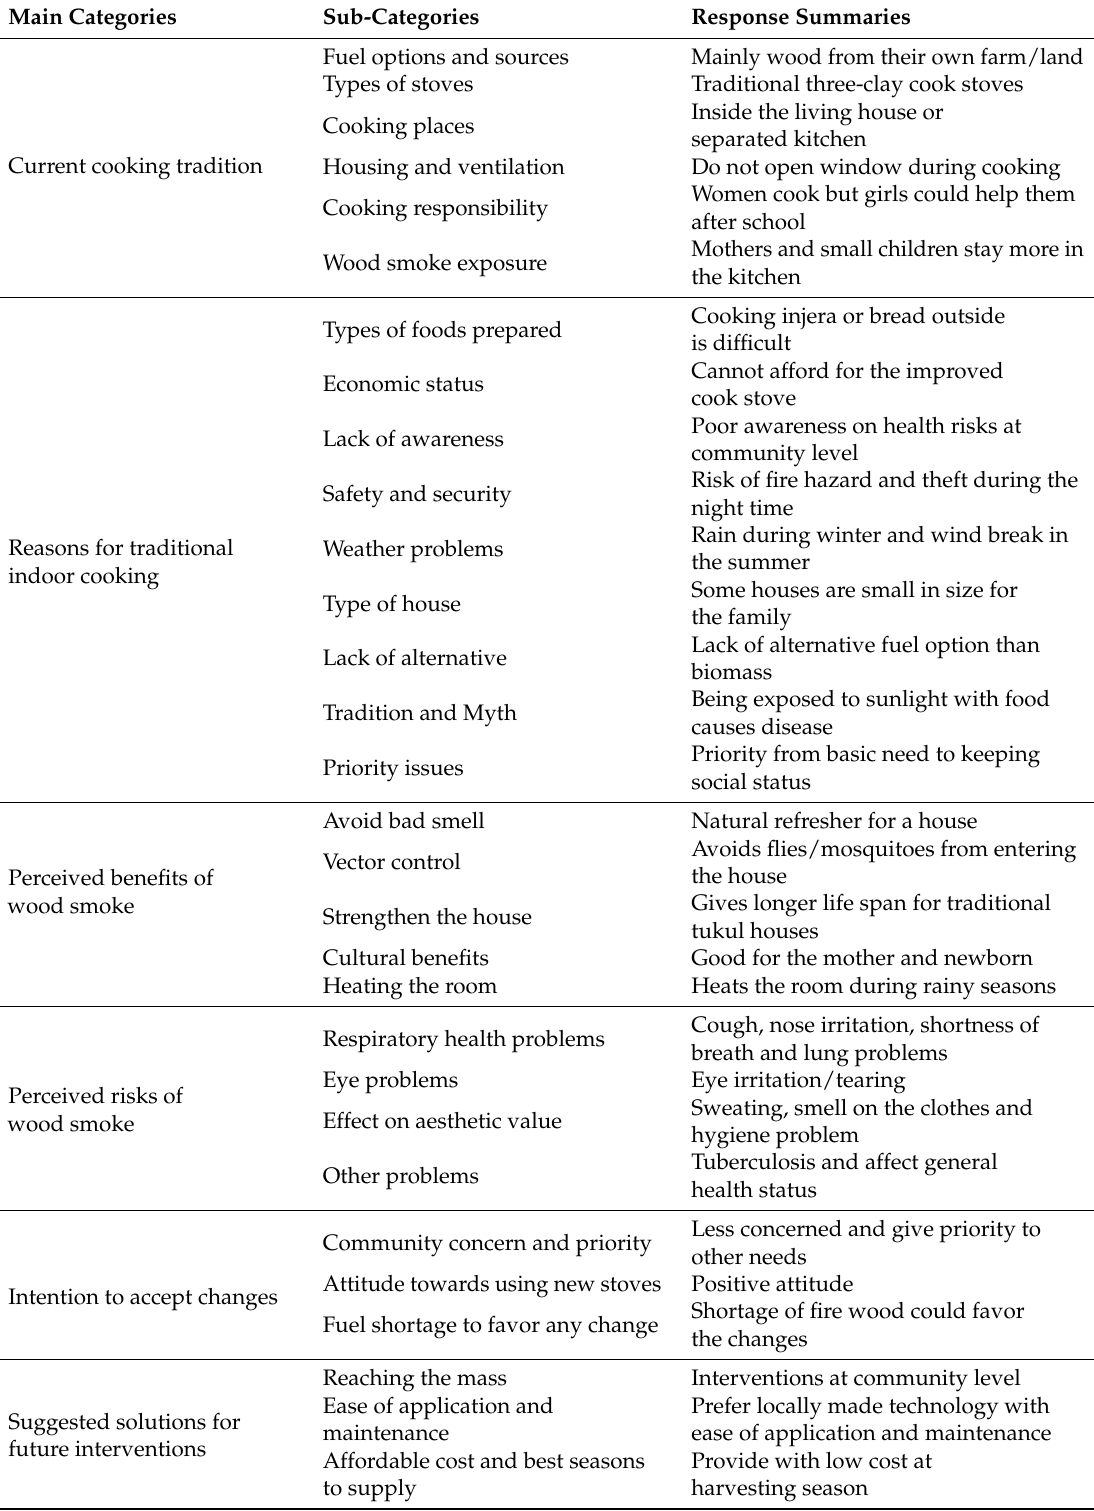
Table 2. Main and sub-categories with response